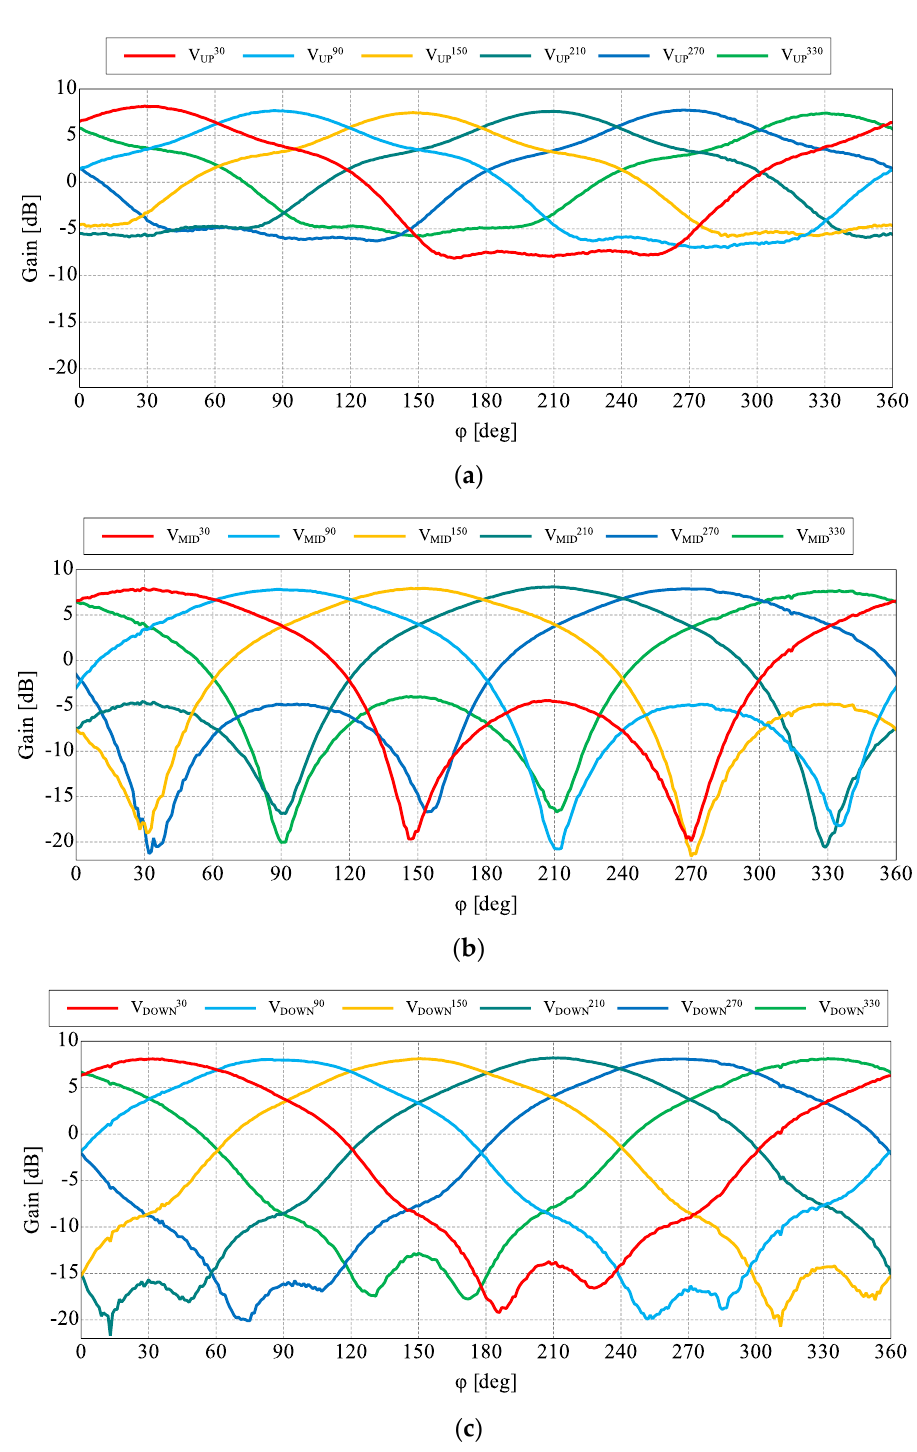
Figure 6. Measured radiation patterns for each configuration in all directions for steering vectors: ( a ) 𝑉 𝑈𝑃𝜑 𝑚𝑎𝑥 , ( b ) 𝑉 𝑀𝐼𝐷𝜑 𝑚𝑎𝑥 , and ( c ) 𝑉 𝐷𝑂𝑊𝑁𝜑 𝑚𝑎𝑥 .